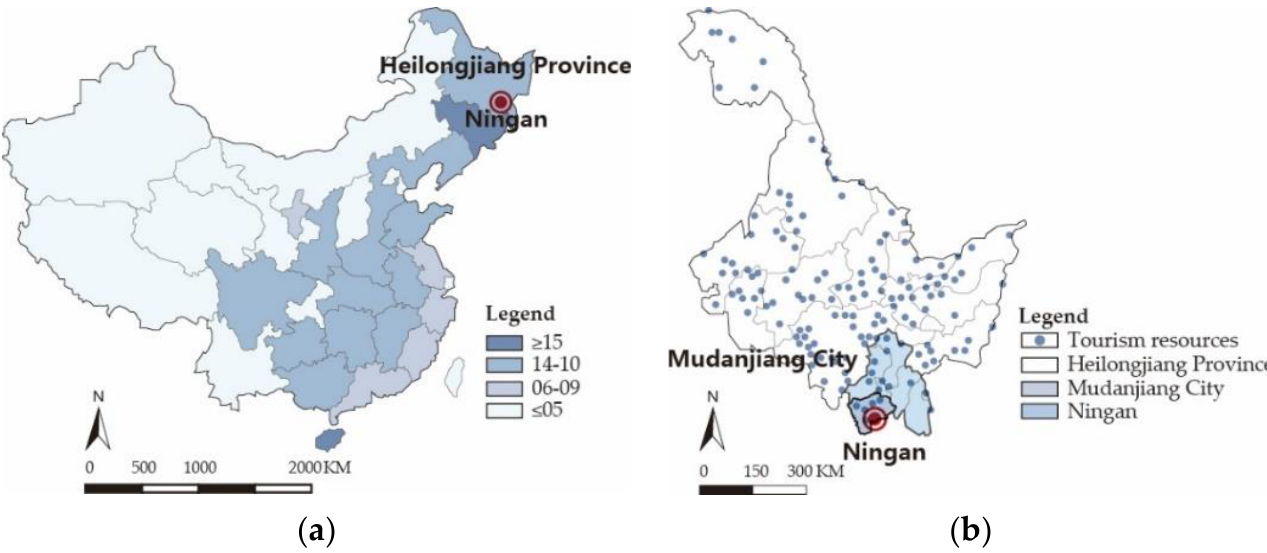
Figure 4. Tourism resources distribution and location of Ning’an: ( a ) construction magnitude for tourism demonstration areas and ( b ) tourism resources distribution.